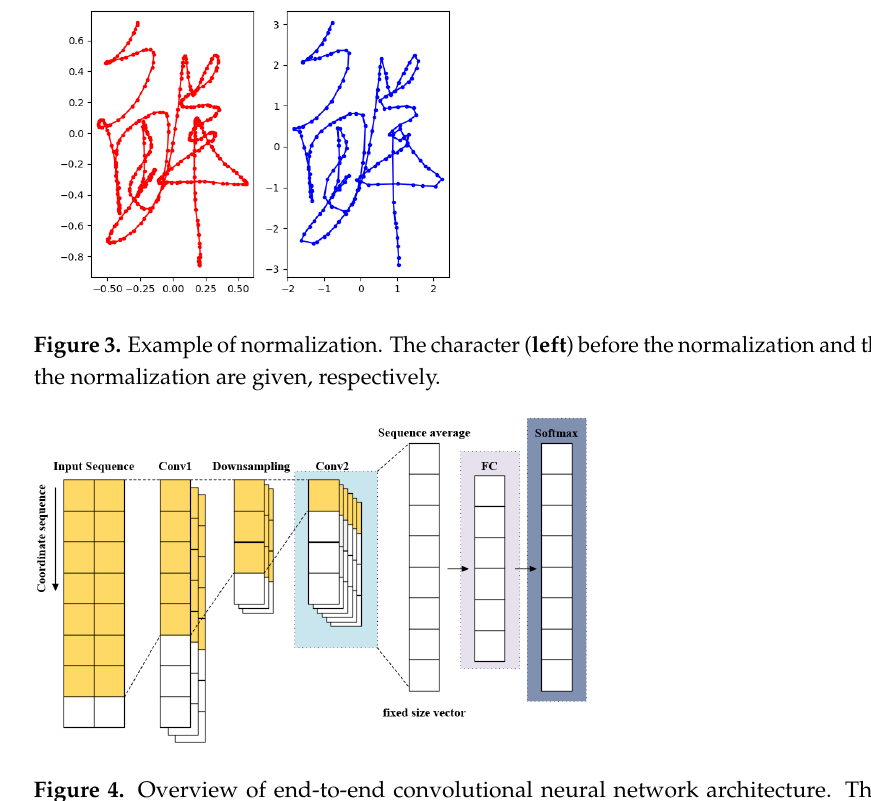
Figure 4. Overview of end-to-end convolutional neural network architecture. The stride of the convolutional layer shown in the figure is 1, and the convolution kernel size is